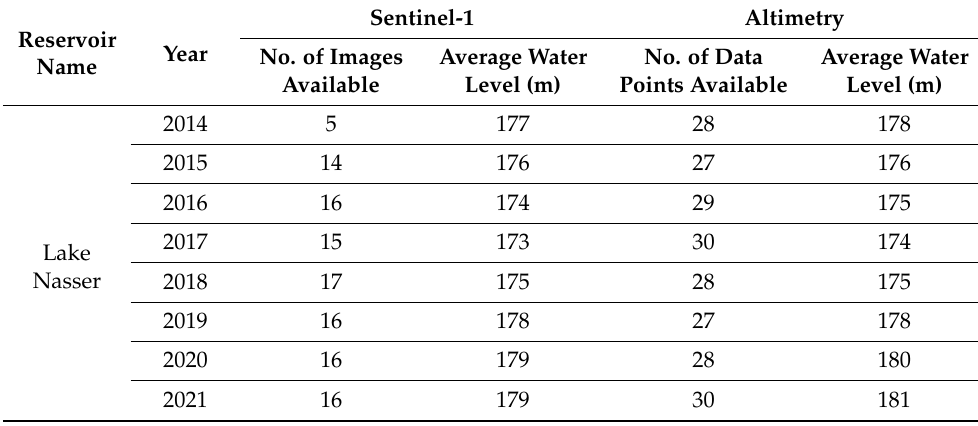
Table 3. Average water levels derived from the two sources for Lake Nasser.